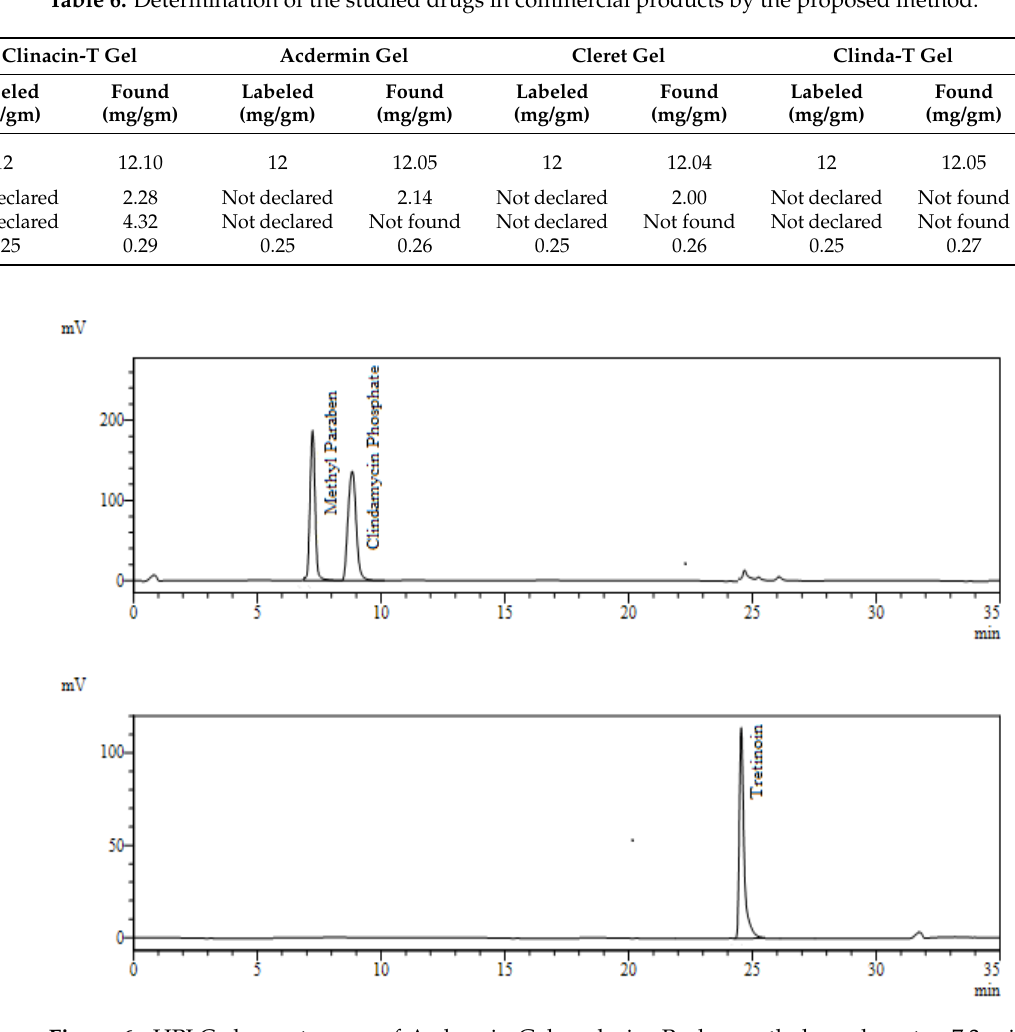
Figure 6. HPLC chromatogram of Acdermin Gel analysis. Peaks: methyl paraben, t R ∼ 7.3 min; clindamycin phosphate, t R ∼ 8.9 min; tretinoin, t R ∼ 24.8